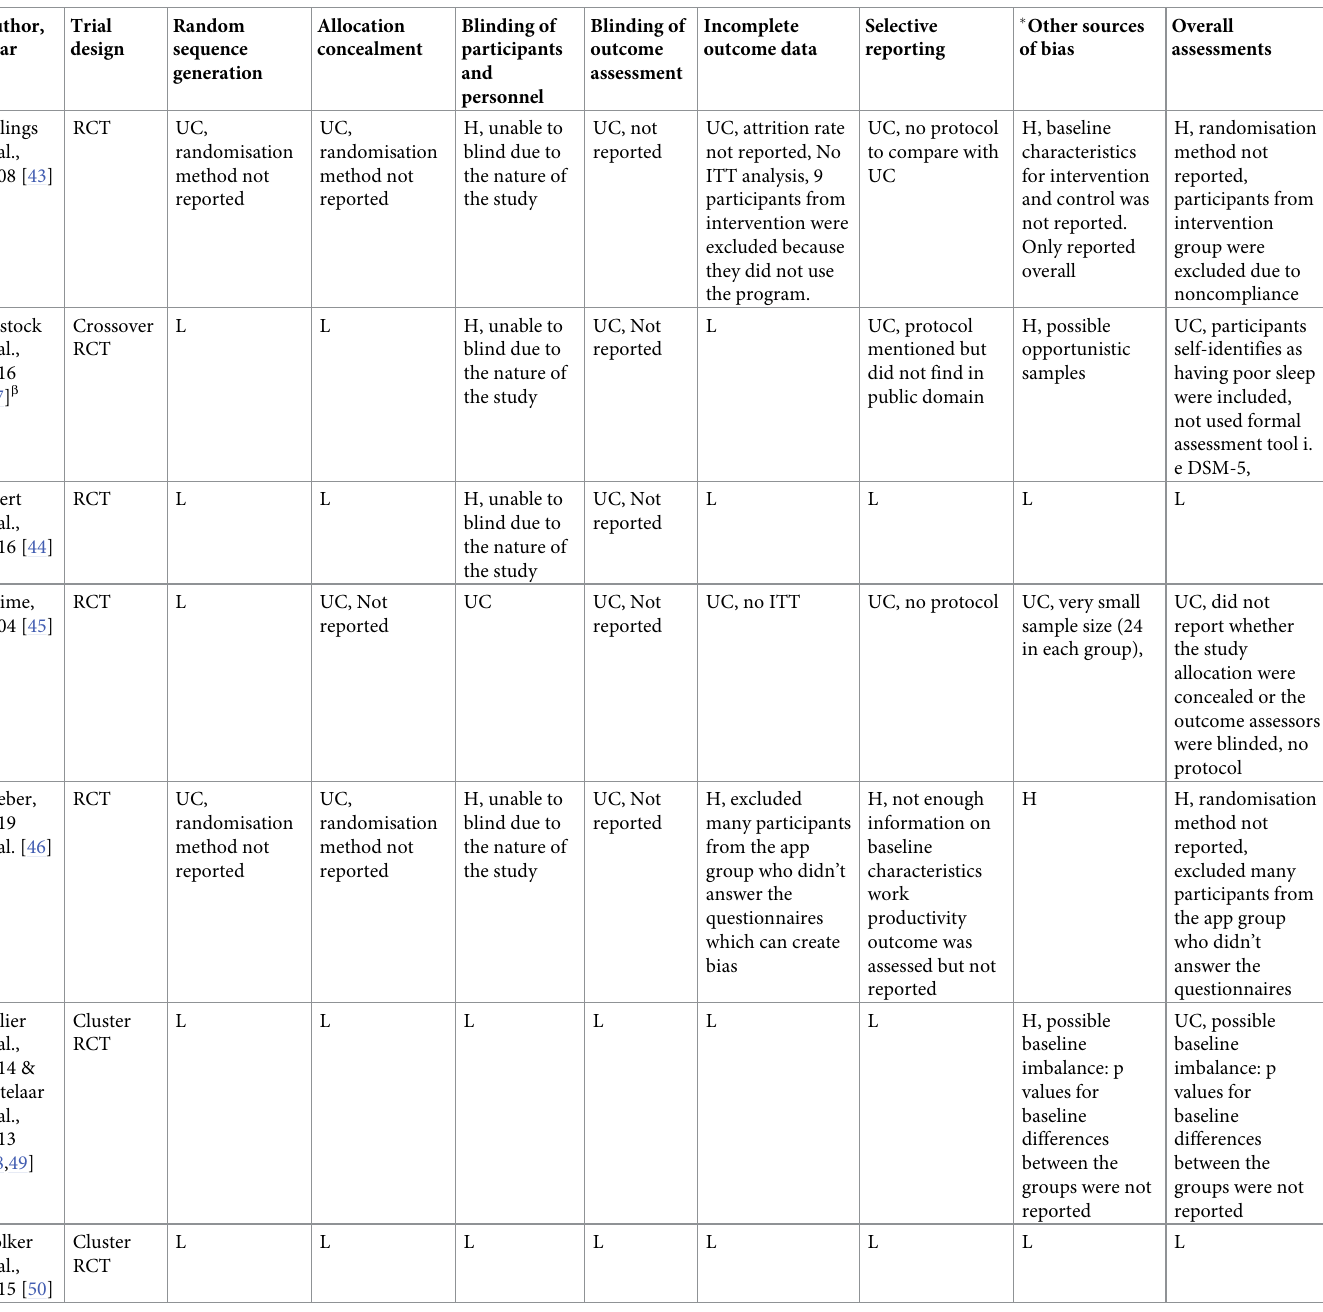
Table 2. Risk of bias in included